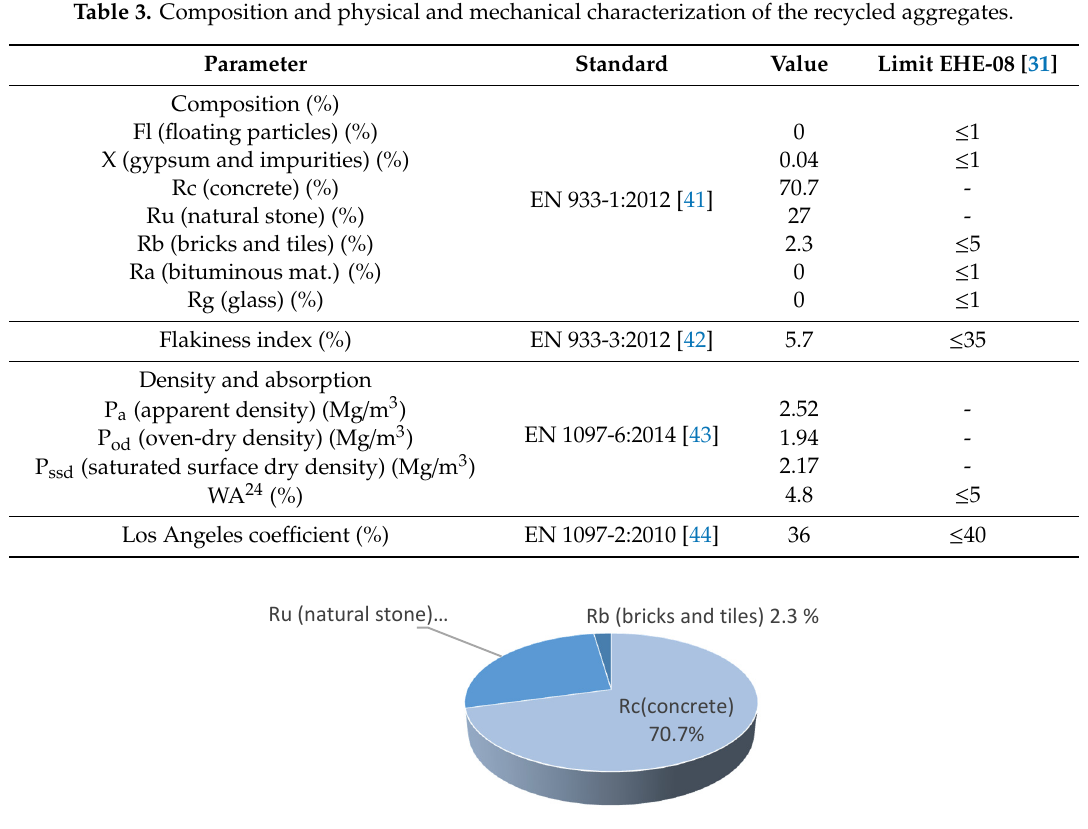
Table 3. Composition and physical and mechanical characterization of the recycled aggregates.